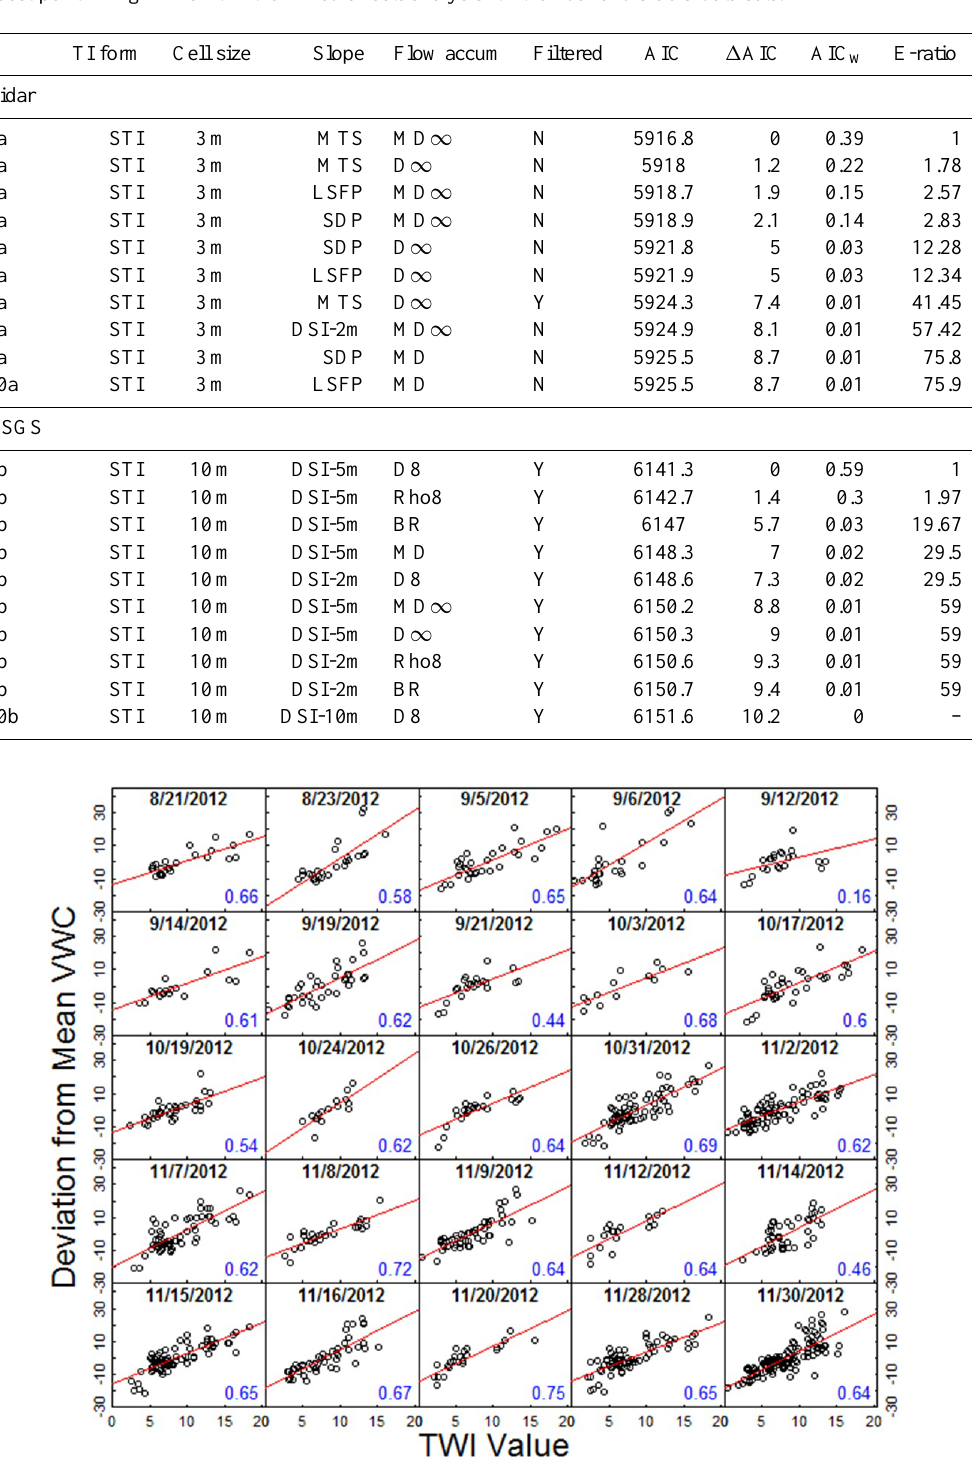
Figure 11. Mean-normalized volumetric water content (%) vs. index value of the optimal TWI for the lidar data set. R 2 values are shown in the lower-right corner of each